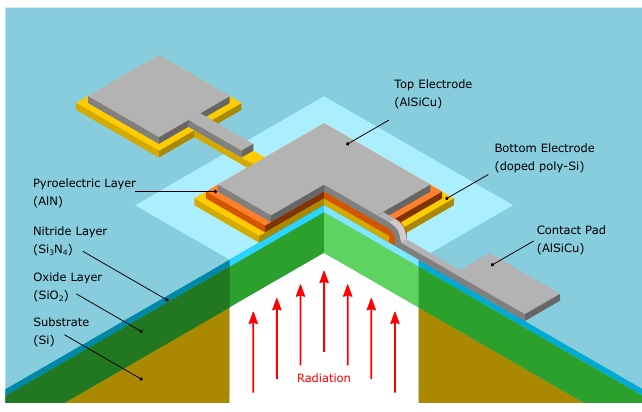
Figure 1. Quarter cut schematic representation of the pyroelectric